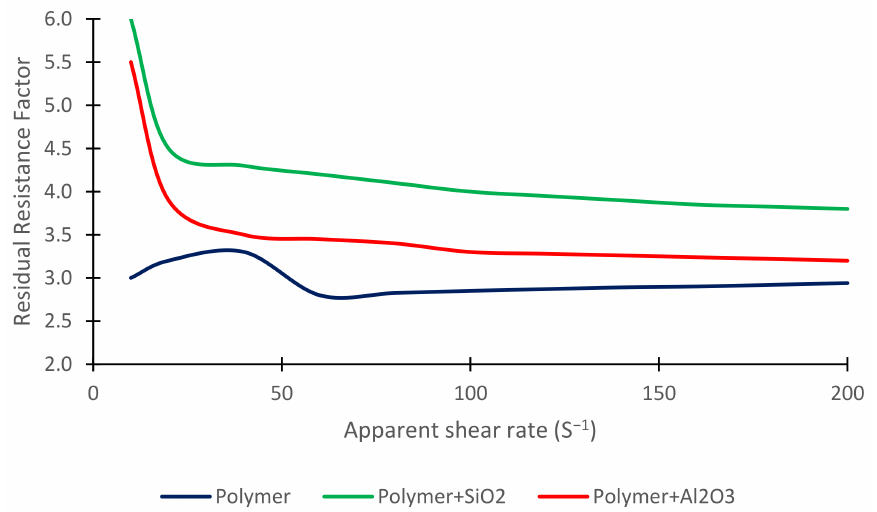
Figure 6. Residual resistance factor versus apparent shear rate for different aqueous solutions at reservoir temperature of 60 ◦ C and pressure of 1200